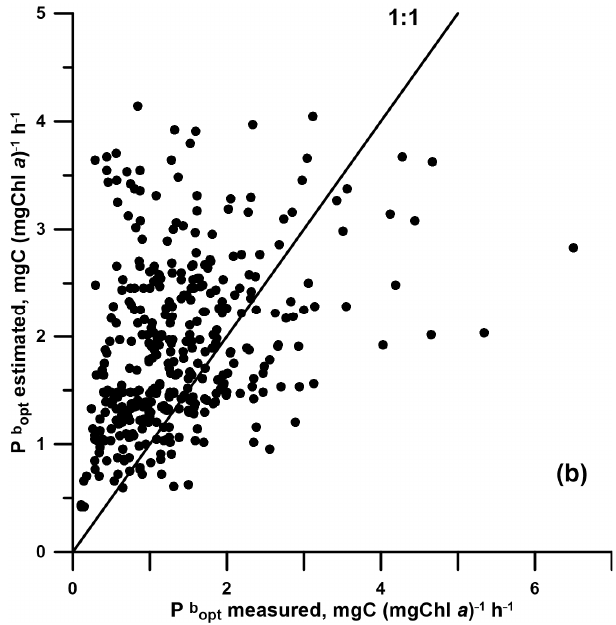
Figure 5. ( a ) A comparison of the values of the optimal assimilation number (P bopt ) measured and calculated using subsurface PAR (E 0 ) and ( b ) a comparison of the values of P bopt measured and calculated using satellite-derived PAR (E sat ) (black points). The solid line indicates 1:1 correlation. The results of E 0reg verification using field observations are represented in Table 6 and Figure 5a. The comparison of the measured and modelled values of P bopt suggests that E 0reg